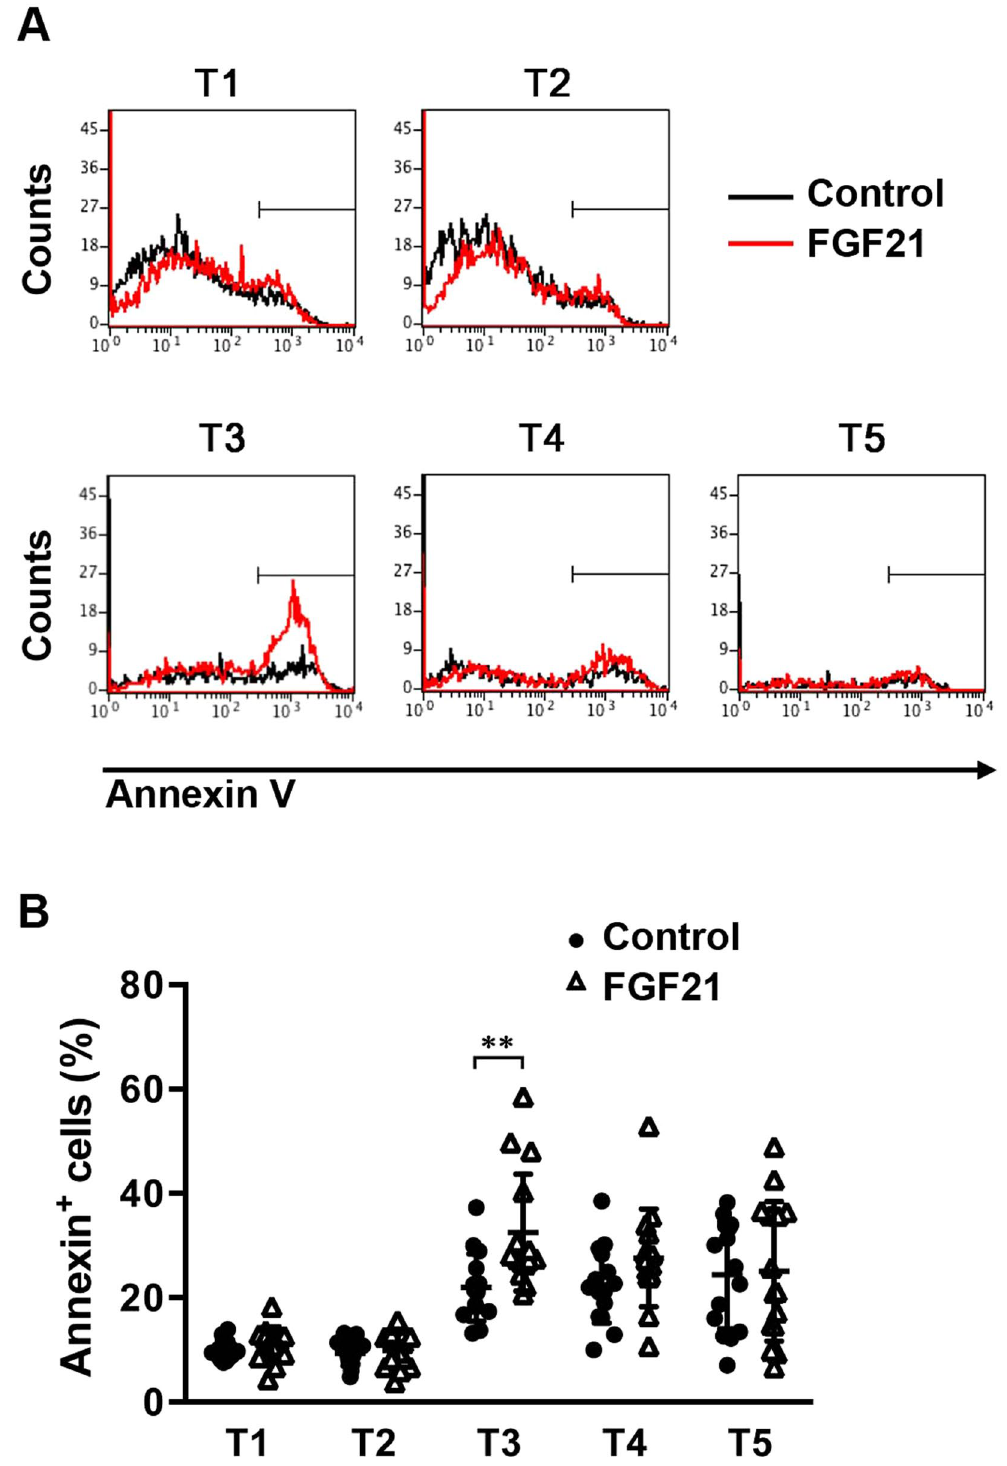
Figure 7. FGF21 treatment results in increased apoptosis of immature thymocytes. FTOC was performed in the presence or absence of recombinant human FGF21 (500 ng/ml) for 14 days. Annexin V staining was performed to detect apoptotic T cells by flow cytometry. ( A ) Representative histograms show the percentage of Annexin V + cells in gated thymocyte subsets. ( B ) Graph showing the analysis of the percentage of Annexin V + cells in thymocytes from FTOCs. All data shown are the mean ± SD. ** P < 0.01 versus